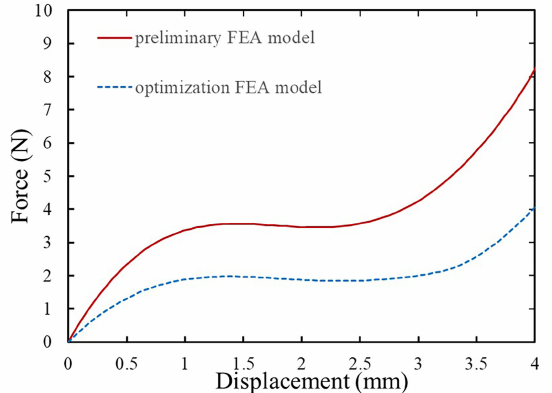
Figure 8. Comparison between preliminary FEA model and optimized FEA